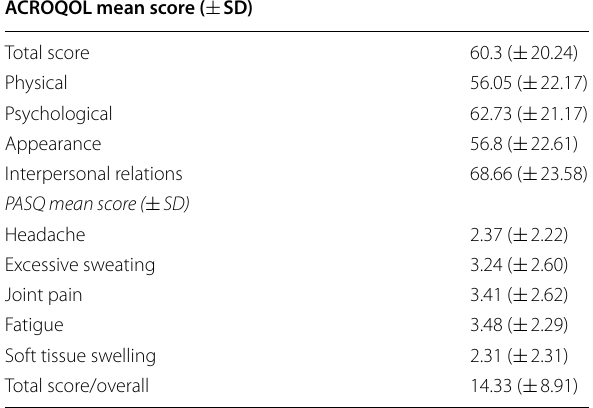
Table 2 Current biochemical and tumoral disease status